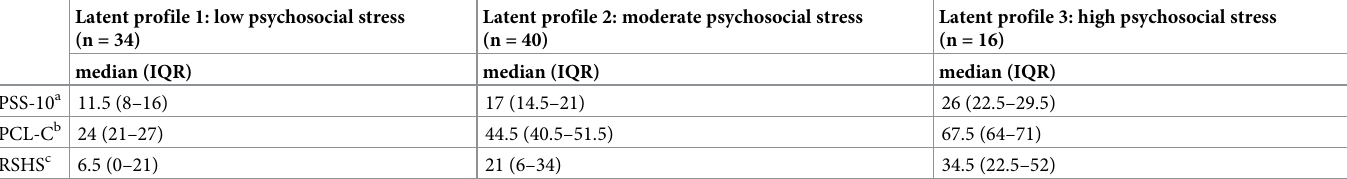
Table 2. Patterns of perceived stress, posttraumatic stress, and race- and gender-based harassment by latent profile membership (3-class model). Latent profile 1: low psychosocial stress (n =